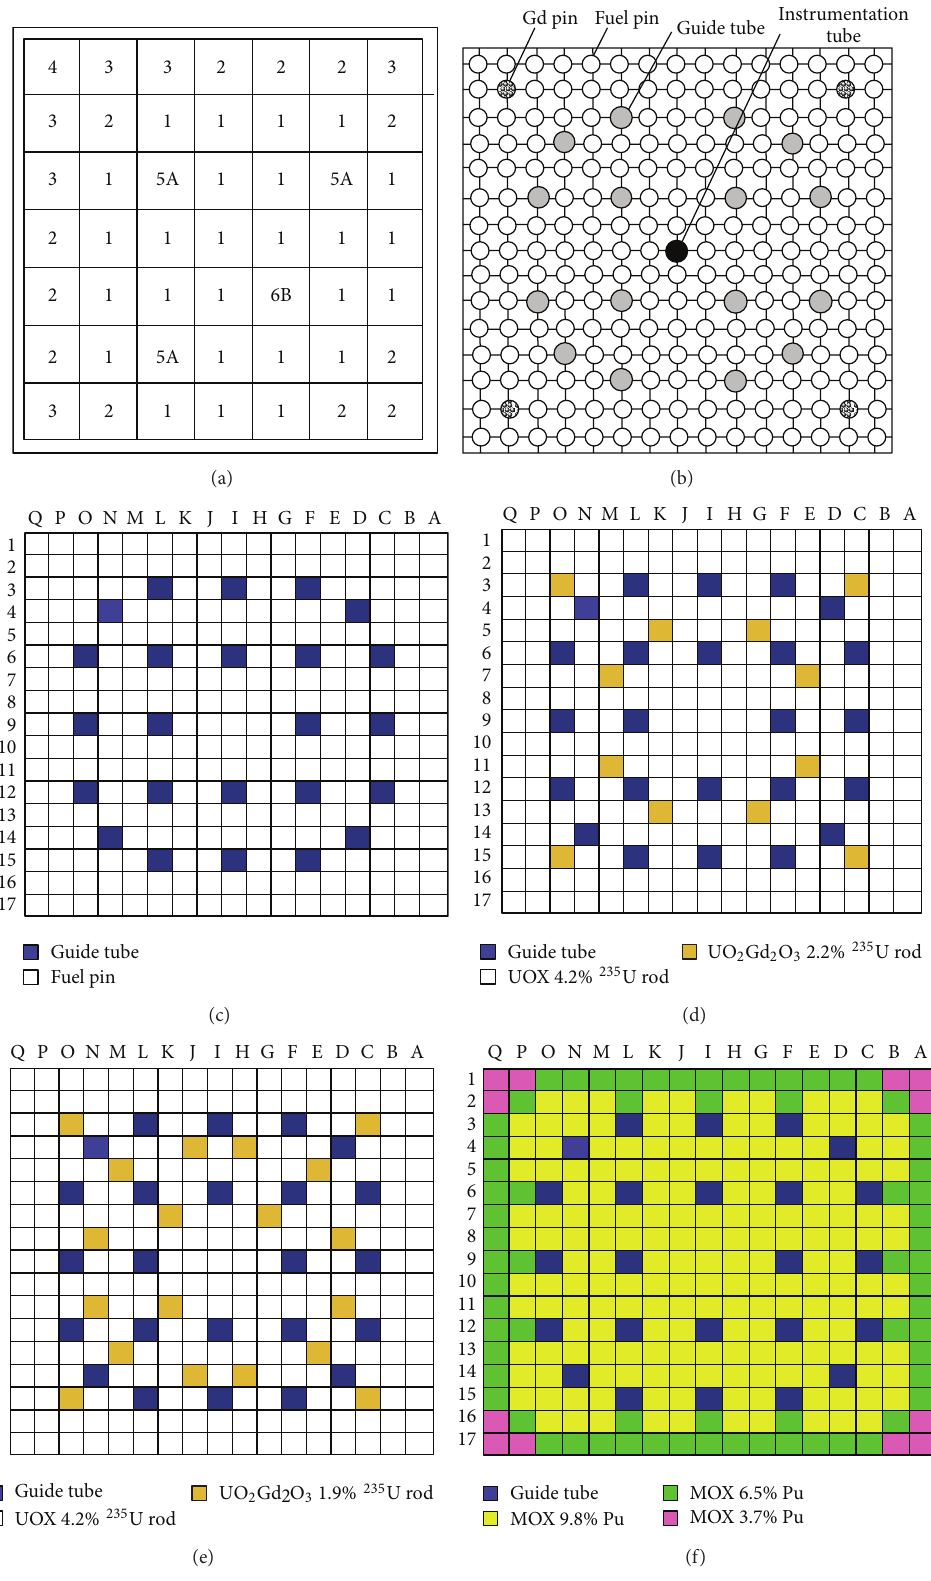
Figure 2: FAs for the test cases of Exercise I-2: BWR (a), PWR (b), GEN-III Type 1 (c), GEN-III Type 2 (d), GEN-III Type 3 (e), and GEN-III Type 4